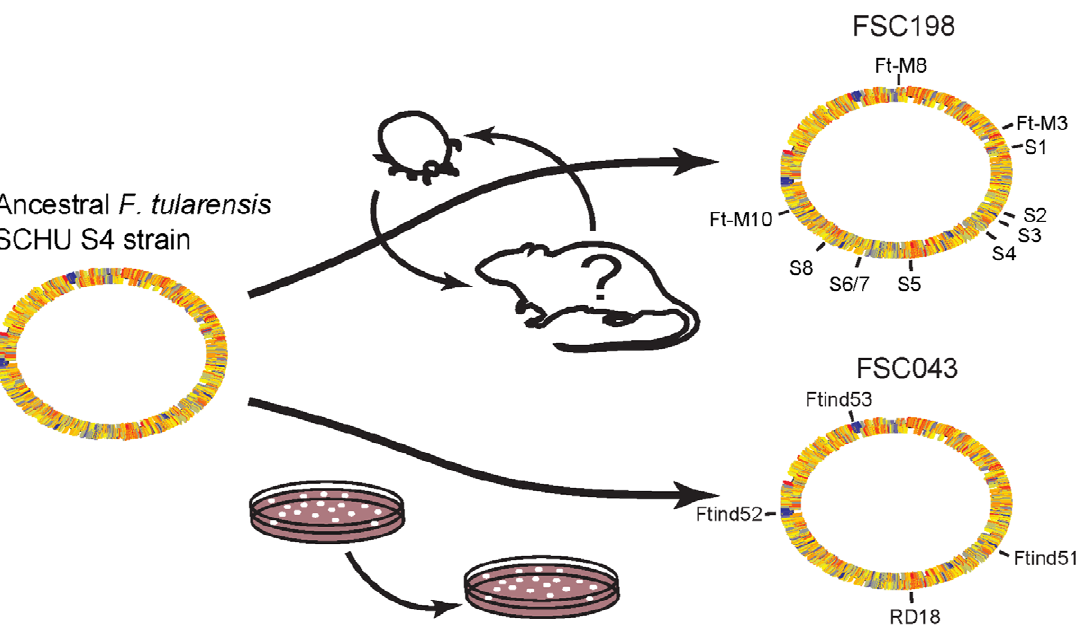
Figure 2. Overview of different paths of evolution. Strain FSC043 and strain FSC198 have been exposed to different environments since their split from the common ancestor strain SCHU S4. Strain FSC043 has experienced ‘artificial’ life cycles inside a laboratory while strain FSC198 has been exposed to a natural environment in Slovakia, which is reflected in their genomes by exhibiting different mutation patterns.